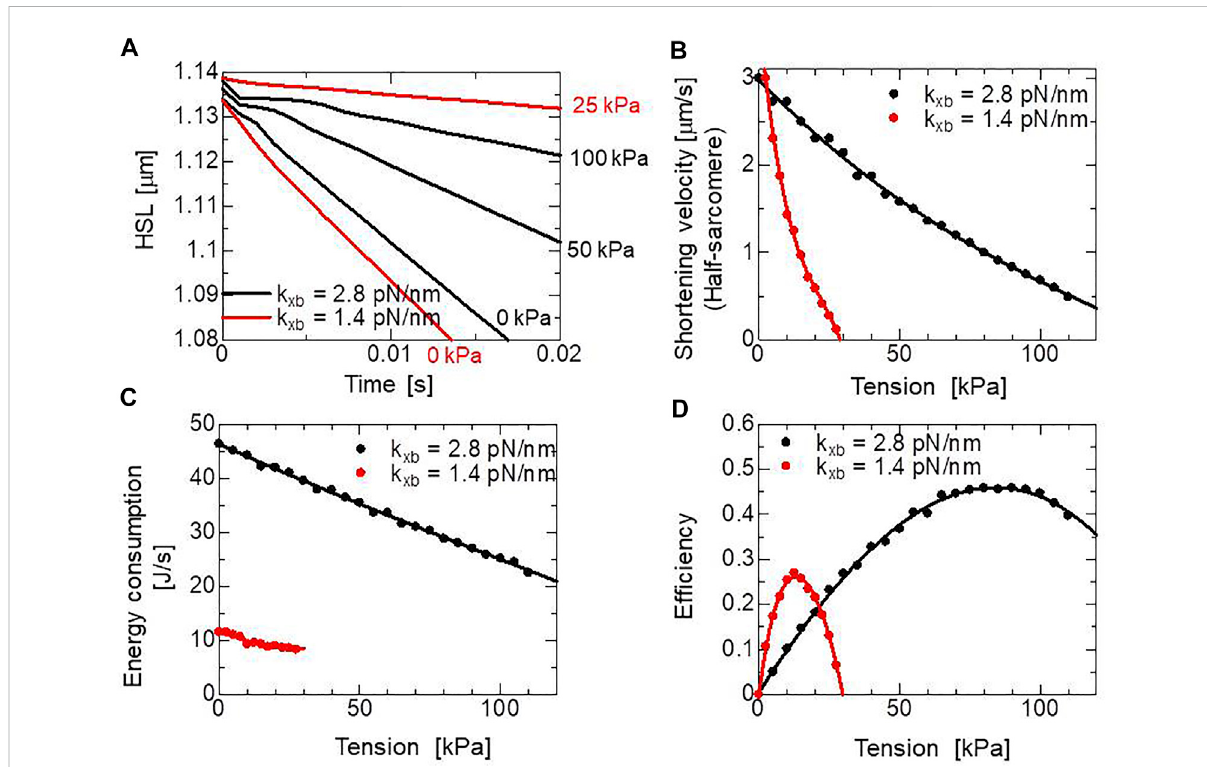
FIGURE 6 Simulated half-sarcomere length changes under isotonic conditions with the two cross-bridge model using different myosin rod stiffnesses, k xb = 1.4 pN/nm and k xb = 2.8 pN/nm. (A) Time courses of the half-sarcomere length under isotonic conditions with isotonic tensions of 0, 50, and 100 kPa for the cross-bridge model with k xb = 2.8 pN/nm, and 0, 25 kPa for the cross-bridge model with k xb = 1.4 pN/nm. (B) Half-sarcomere shortening velocities under isotonic tensions after the release starting from the half-sarcomere length at 1.14 μ m ( λ (cid:2) 1 . 2). The velocities were calculatedfromchangesofthehalf-sarcomere lengthfrom1.12to1.09afterthereleaseunderisotonicconditions,where[Ca 2+ ]was fi xedat0.4 μ M. (C) The energy consumption rate per the left ventricular wall volume (157 ml) of the ventricle model. (D) Ef fi ciencies for shortening under isotonic